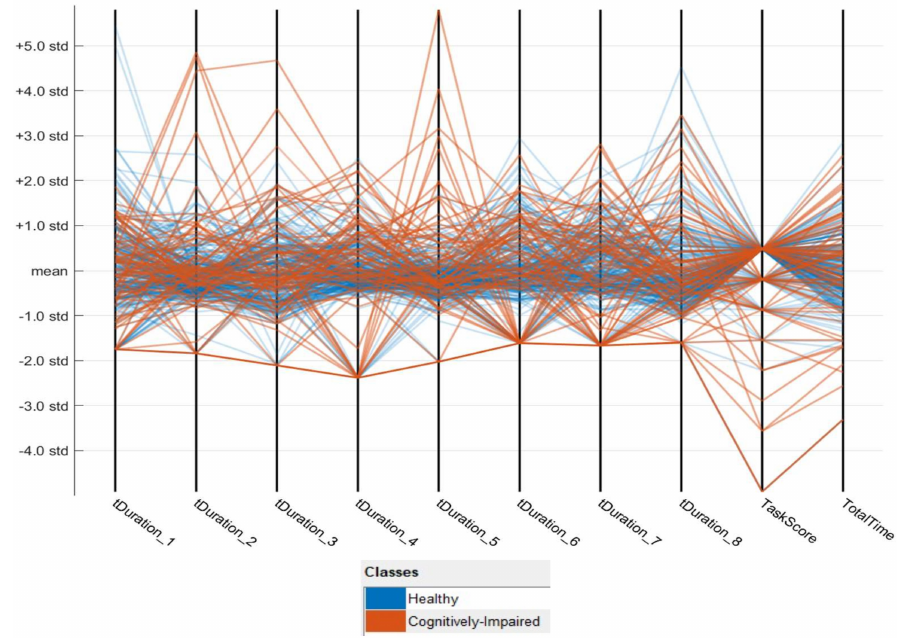
Figure 5. Parallel coordinates plot of cognitively impaired vs healthy using standard deviation.